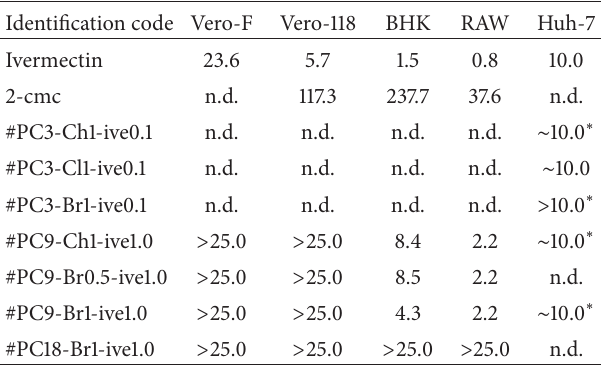
Table 2: Half maximal cytotoxic concentration (CC 50 ) expressed in 𝜇 M for ivermectin and ivermectin-loaded liposomal formulations. Identification code Vero-F Vero-118 BHK RAW